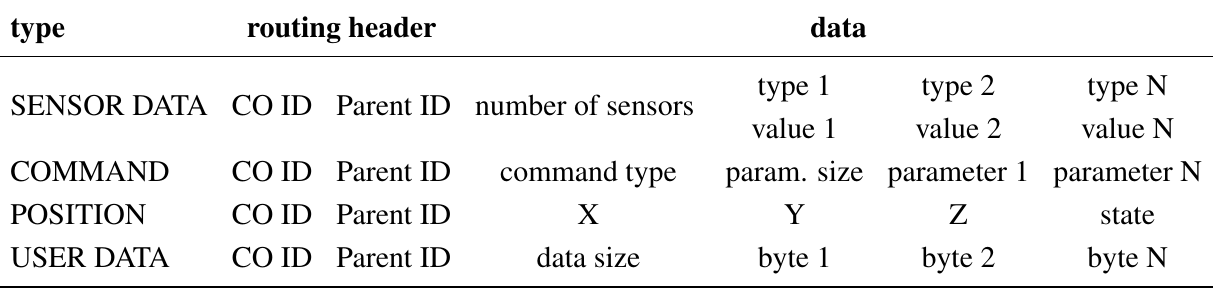
Table 4. Examples of messages in the robot-WSN interface.